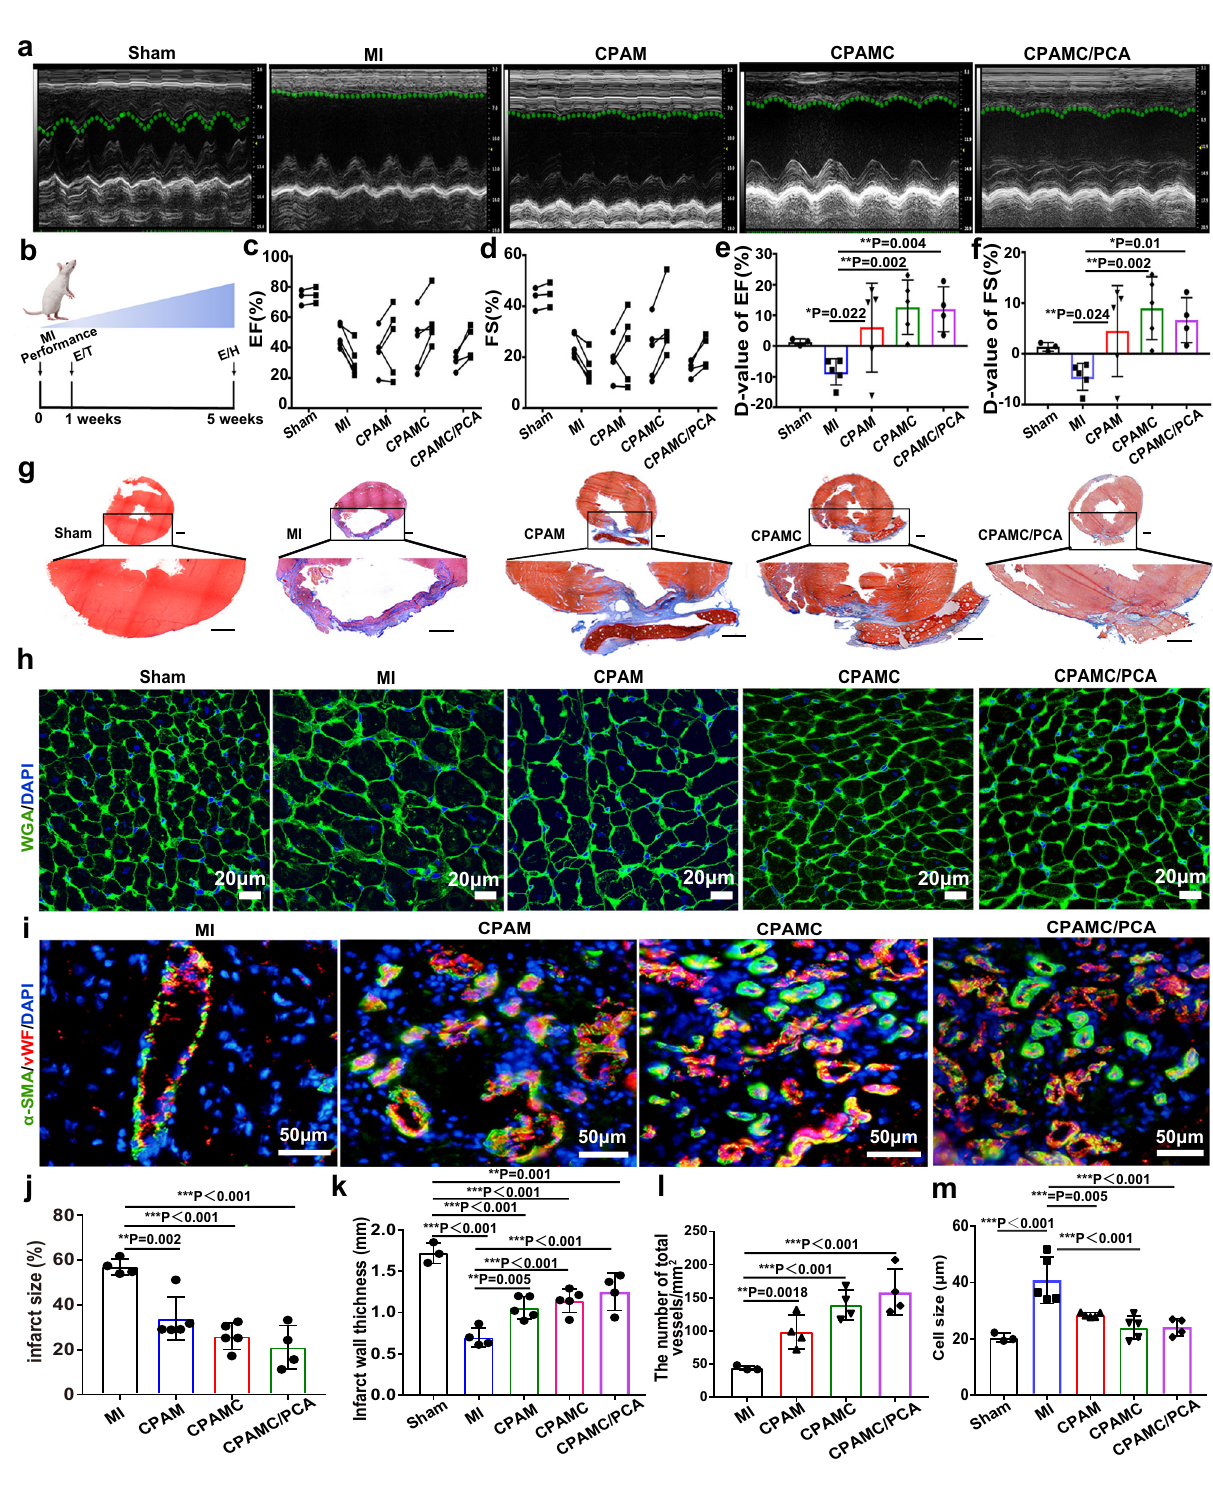
Fig. 6 | Anti-oxidation capacity and anti-in fl ammatory effect of hydrogels. a Live-dead staining of CMs on CPA hydrogel, CPAM hydrogel, and CPAMC hydrogel after 500 μ M H 2 O 2 treatment (above). The detection of ROS level in CMs on CPA hydrogel, CPAM hydrogel, and CPAMC hydrogel after 500 μ M H 2 O 2 treatment (bottom). b Polarization of RAW264.7 cells on different hydrogels after 24 hours of LPS treatment at 100ng/mL. c CMs activity ( n =3 independent sam- ples), d SODlevel( n =3independentsamples),and e MDAlevel( n =4independent